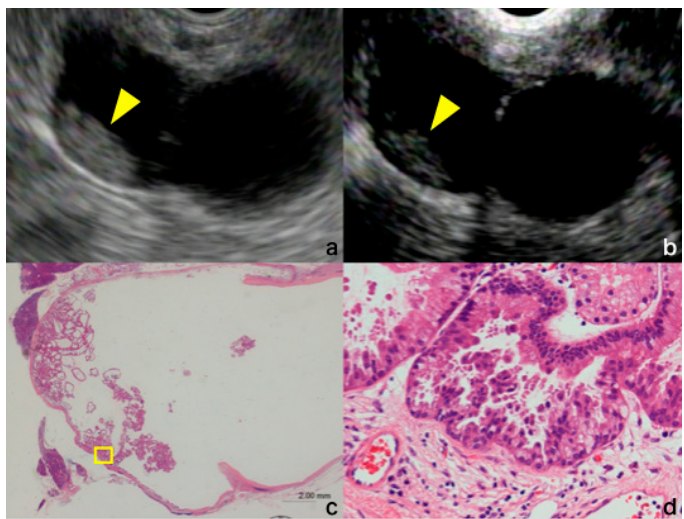
Figure 1. ( a ) Fundamental B-mode EUS showing a suspected mural nodule (arrowhead); ( b ) Contrast-enhanced harmonic EUS showing lesion enhancement and a definitive diagnosis of mural nodule (arrowhead); ( c , d ) Histopathological examination: structural atypia, nuclear enlargement, and irregular papillary structure are evident. EUS, endoscopic ultrasound.